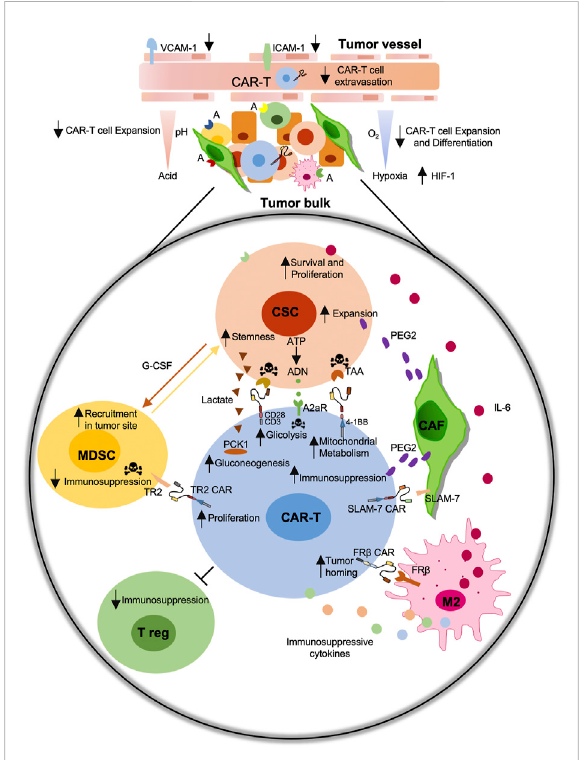
Schematic representation of the immunosuppressive role of the tumor microenvironment (TME) on the CAR-T cell ef fi ciency. Immunosuppressive tumor microenvironment (TME) including cancer-associated fi broblast (CAFs), M2-macrophages, myeloid-derived suppressor cells (MDSCs), regulatory T cells (Treg) negatively affect CAR-T cell activity against Cancer Stem Cells (CSCs). The development of CAR-T cell-based strategies against CSC-speci fi c tumor associated antigens (TAAs), including EpCAM, CD44v6, CD166, c-Met, CD133, or against speci fi c TME components antigens (A) including TR2, FR β , SLAM-7 improve their